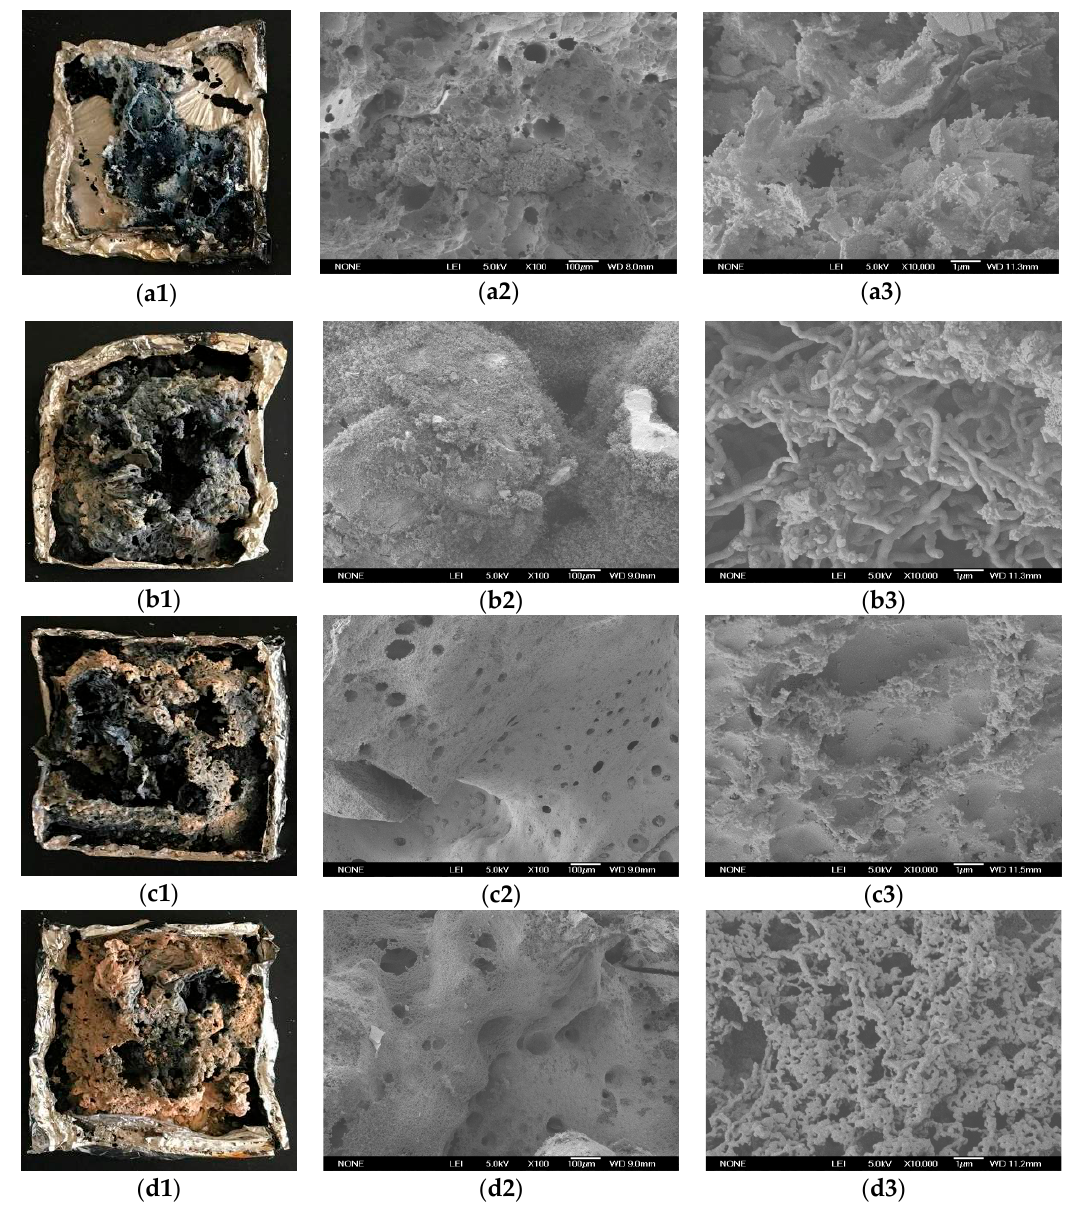
Figure 5. Digital photographs and SEM images of cone calorimeter residues of the neat PBT and its composites: ( a ) neat PBT; ( b ) 1 wt % nano-Sb 2 O 3 composites; ( c ) 3 wt % nano-Sb 2 O 3 composites; ( d ) 5 wt % nano-Sb 2 O 3 composites, in the cone calorimeter tests at a heat flux of 50 kW/m 2 .